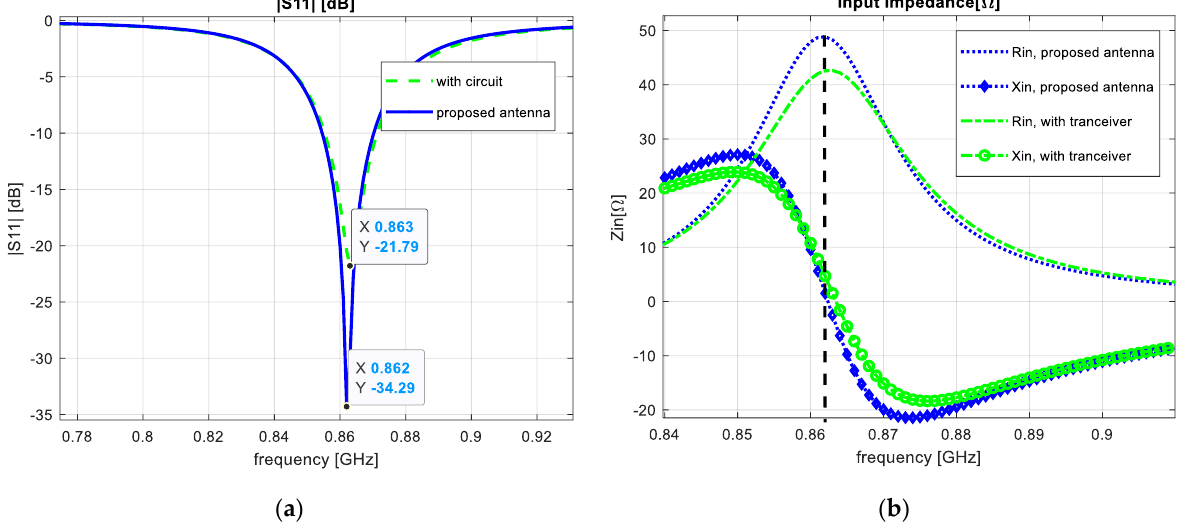
Figure 11. Transceiver influence: ( a ) reflection coefficient; ( b ) input impedance.